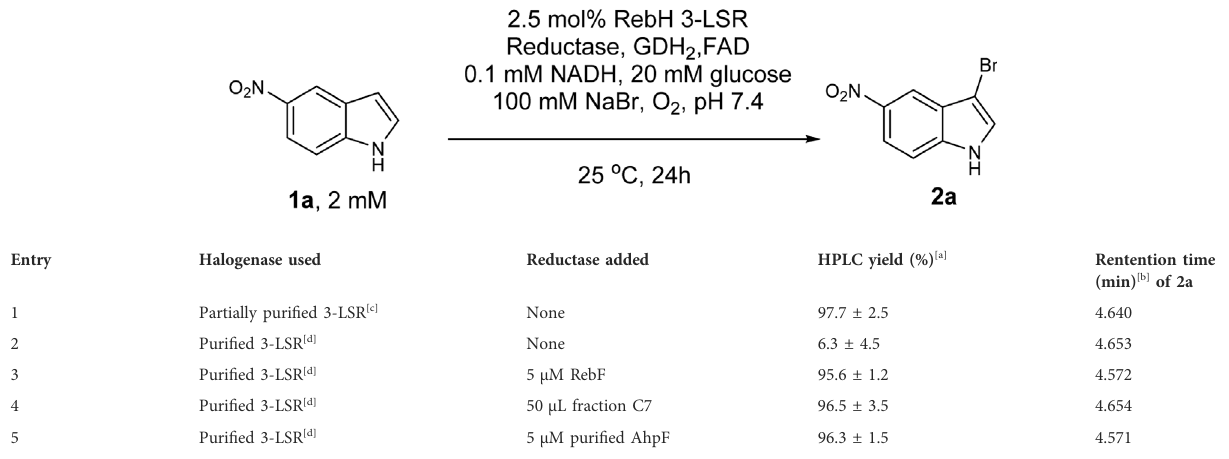
TABLE 1 Bromination of 5-nitroindole with RebH 3-LSR.